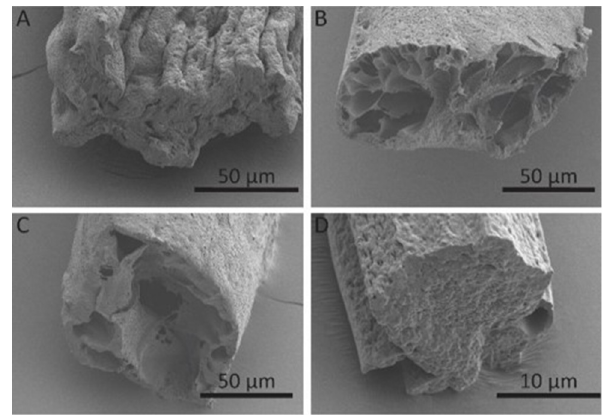
Figure 5. SEM images (cross-sections) of TPU fibers spun at ( A ) r = 2; ( B ) r = 20; ( C ) r = 50; ( D ) r = 100.